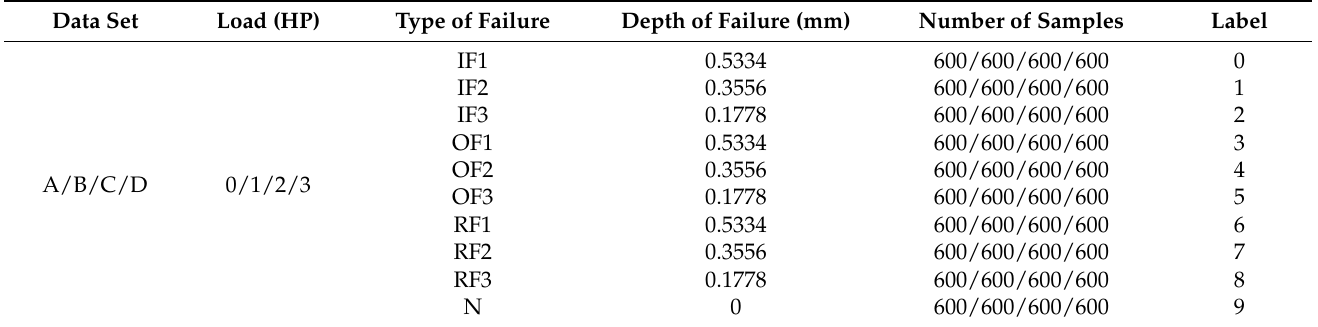
Table 1. The test 1 data set detailed partition